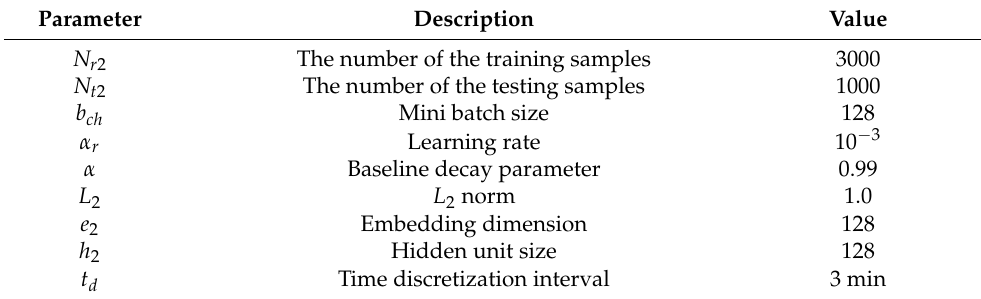
Table 7. Parameter settings in the training process for active debris removal planning.